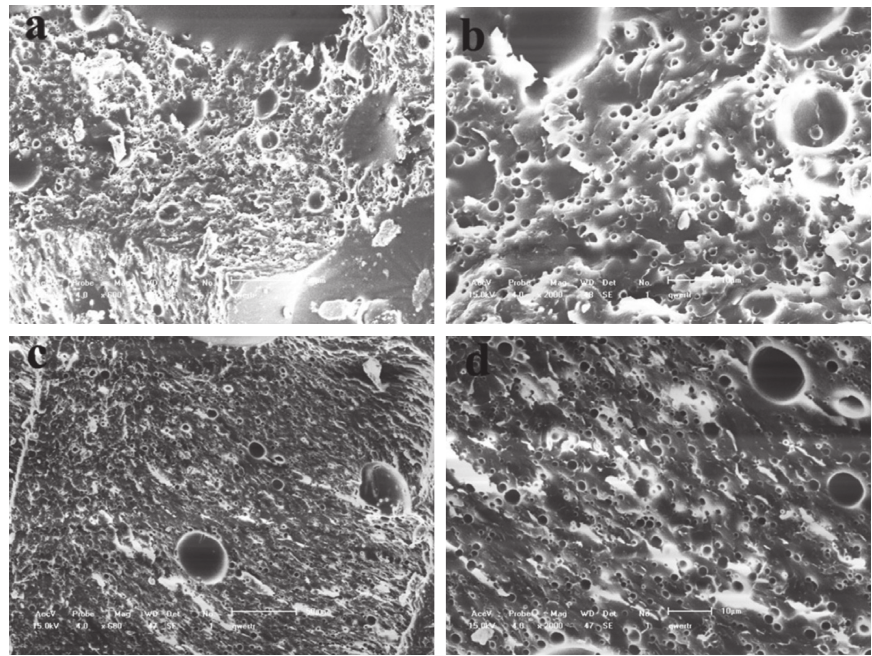
Figure 12: SEM micrographs of ER (a, b) and EA (c, d). (a, c) 600 × and (b, d) 2000 ×